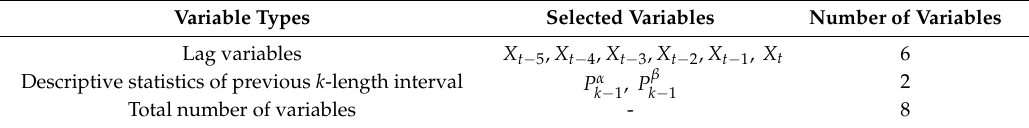
Table 1. Selected variables to predict 𝑃 𝑘𝛼 and 𝑃 𝑘𝛽 of the 𝑘 -length interval [𝑡 + 1, 𝑡 + 𝑘] . Variable Types Selected Variables Number of Variables Descriptive statistics of previous 𝑘 -length interval